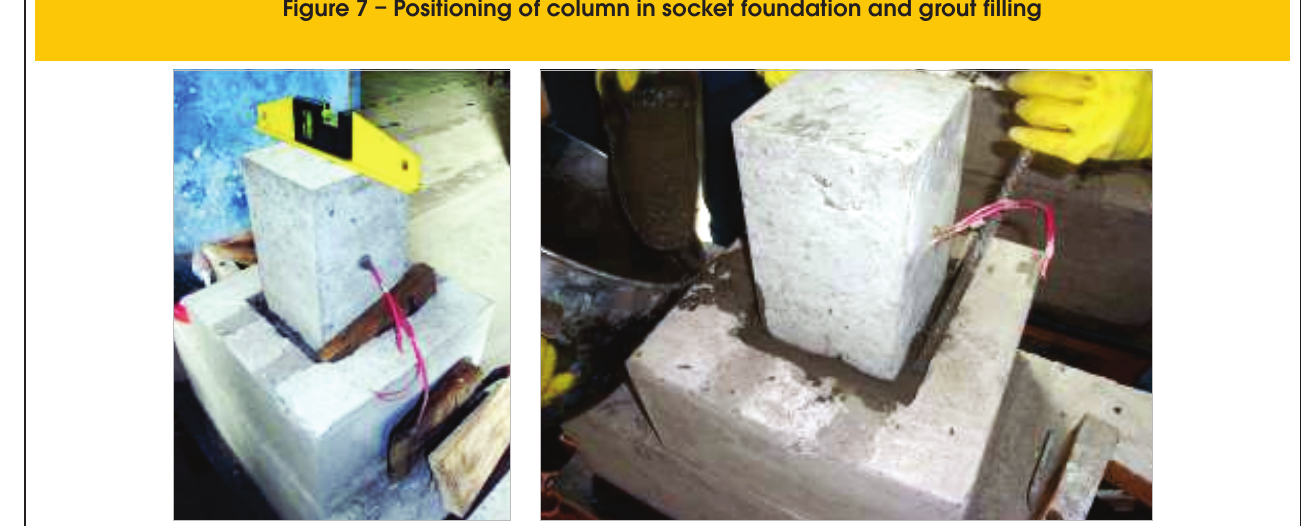
Figure 7 – Positioning of column in socket foundation and grout filling